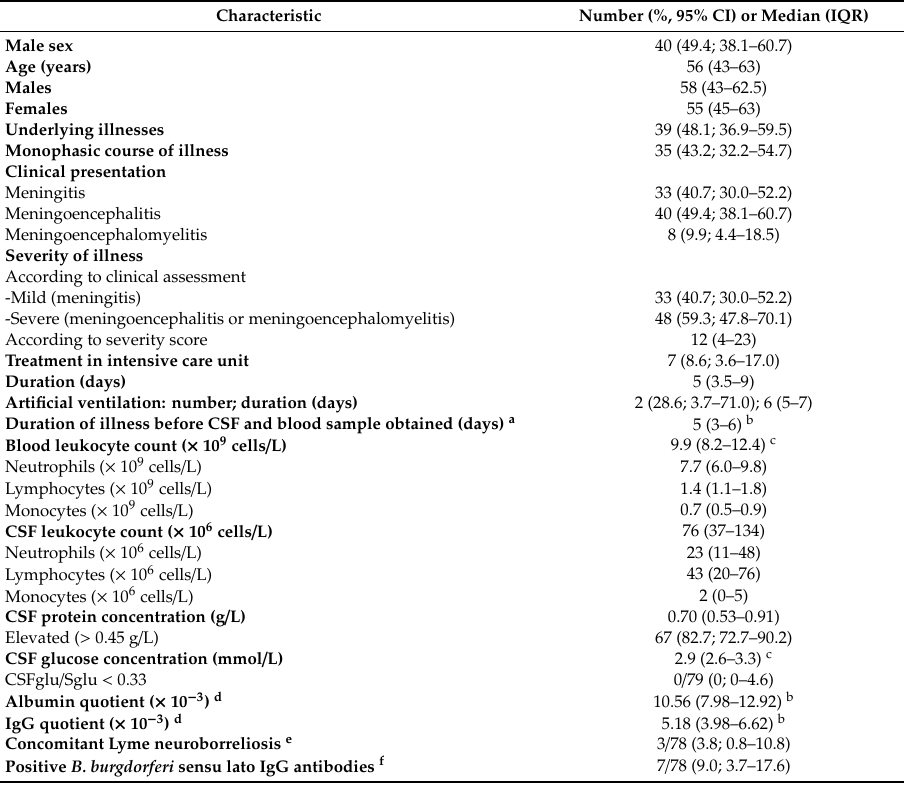
Table 1. Demographic, Clinical, and Laboratory Data on the Acute Illness for 81 Adult Patients with Tick-Borne Encephalitis in whom Levels of Cytokines and Chemokines in Serum and Cerebrospinal Fluid were